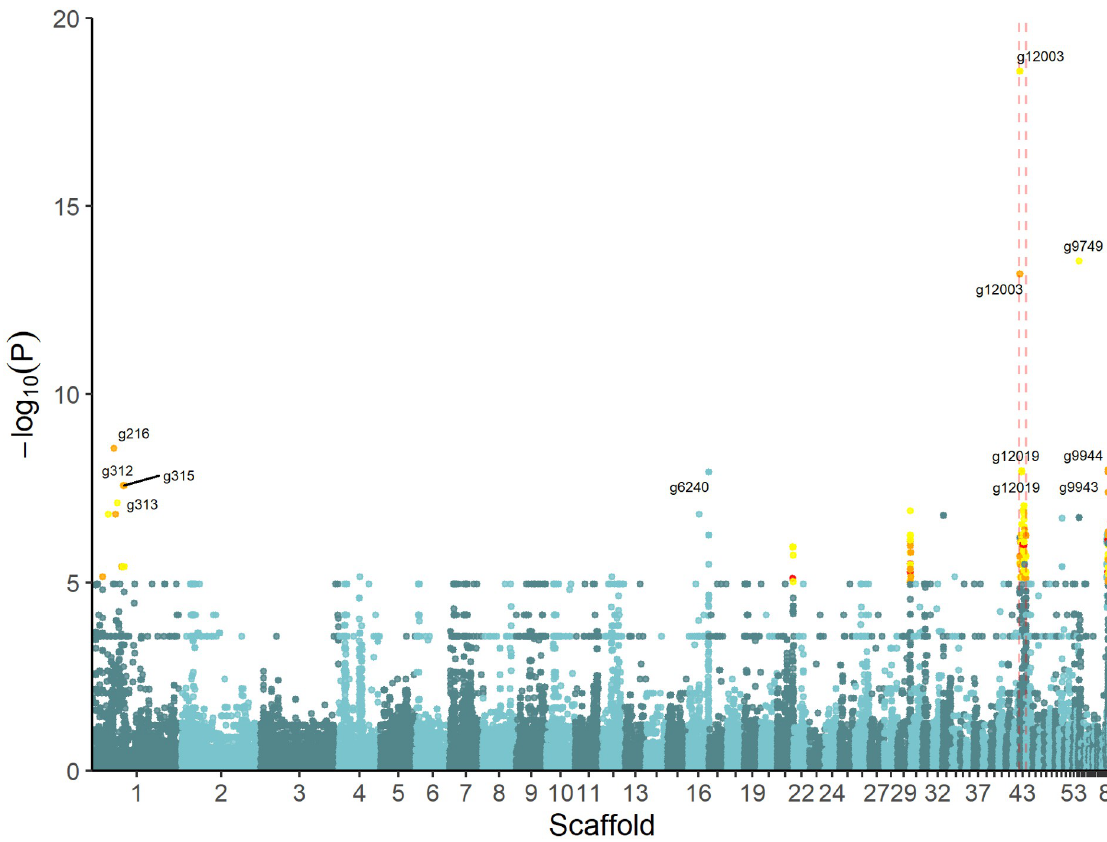
Fig 5. Manhattan plot shows SNPs associated with sorbic acid resistance. Scaffolds are listed on the x-axis, while the y-axis display the significance of the association ( − log 10 (p-value)). Yellow, orange and red dots indicate ‘low’, ‘moderate’ or ‘high’ impact SNPs as determined by SNPeff, respectively. The GeneIDs associated with the SNPs with a − log 10 (p-value) > 7.5 are indicated. The SORBUS cluster is located between the dashed lines.